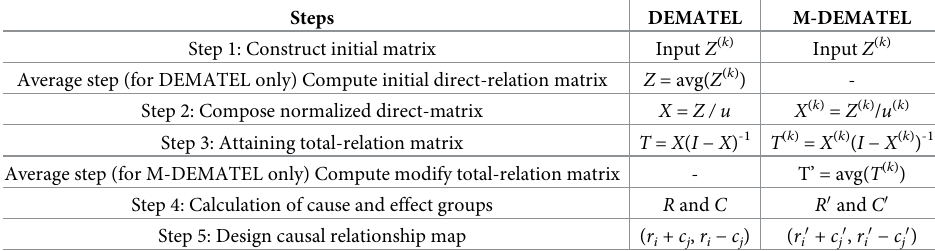
Table 1. The procedures of DEMATEL and